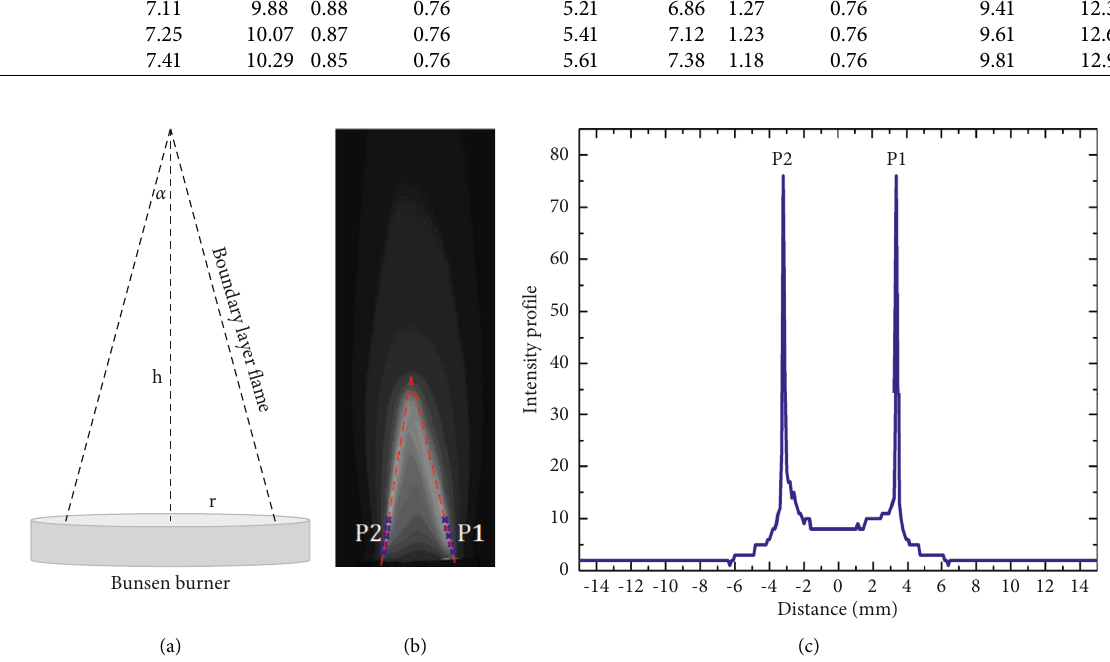
Figure 1: Illustration of the parameters of the Bunsen flame: (a) schematic of flame height h flame half-cone angle α , and flame radius r ; (b) the contour of the flame; and (c) flame intensity